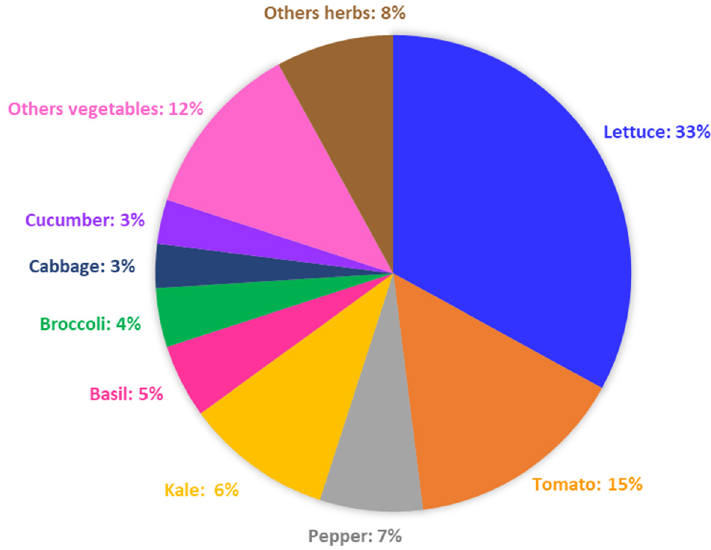
Figure 6. The pie chart shows the relative percentage of published research reported in the literature and used in this review for the different types of vegetables and herbs treated with LED